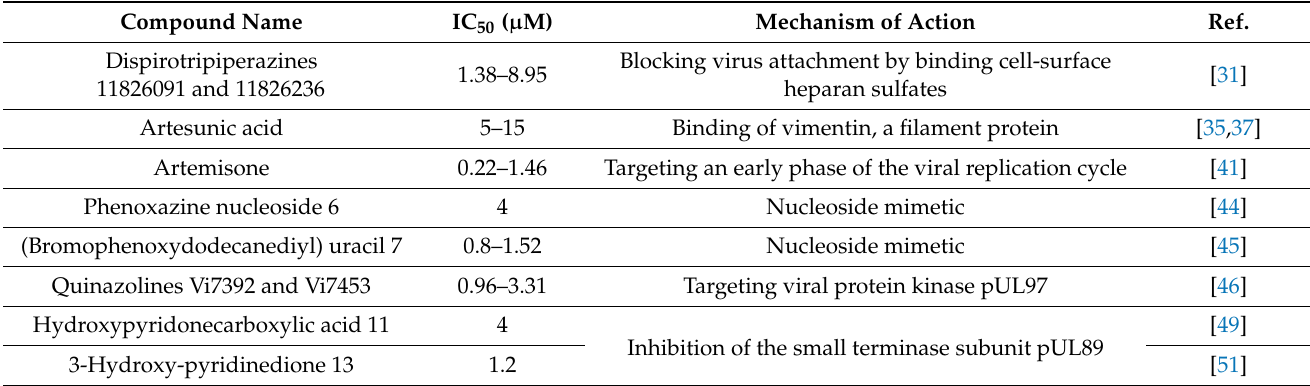
Table 1. Overview of novel HCMV